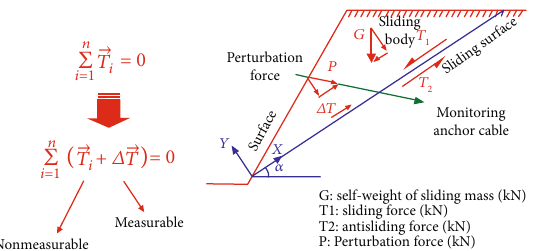
Figure 12: Reinforce and monitoring principle of CRLD cable.